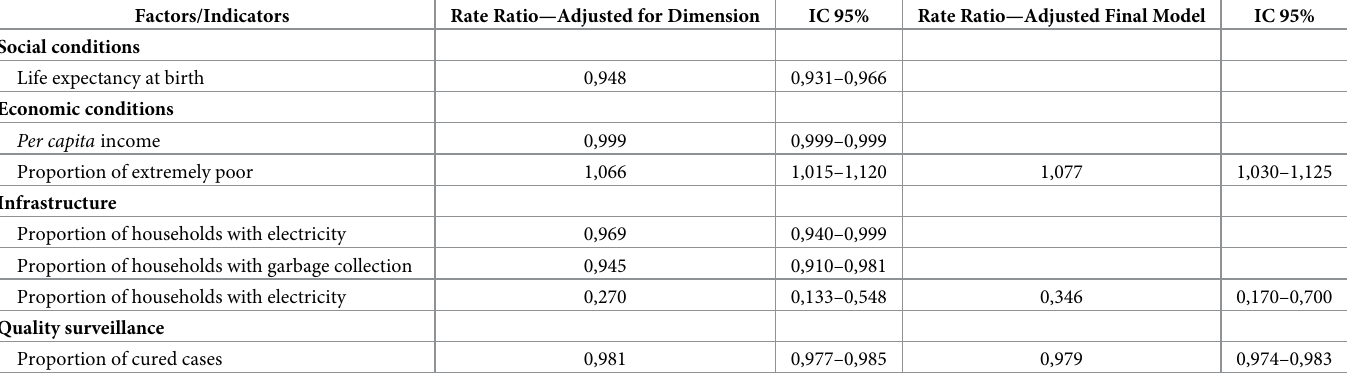
Table 3. Rate ratio of the selected variables of each dimension for the tuberculosis treatment non-adherence according to the Poisson multivariable regression model.